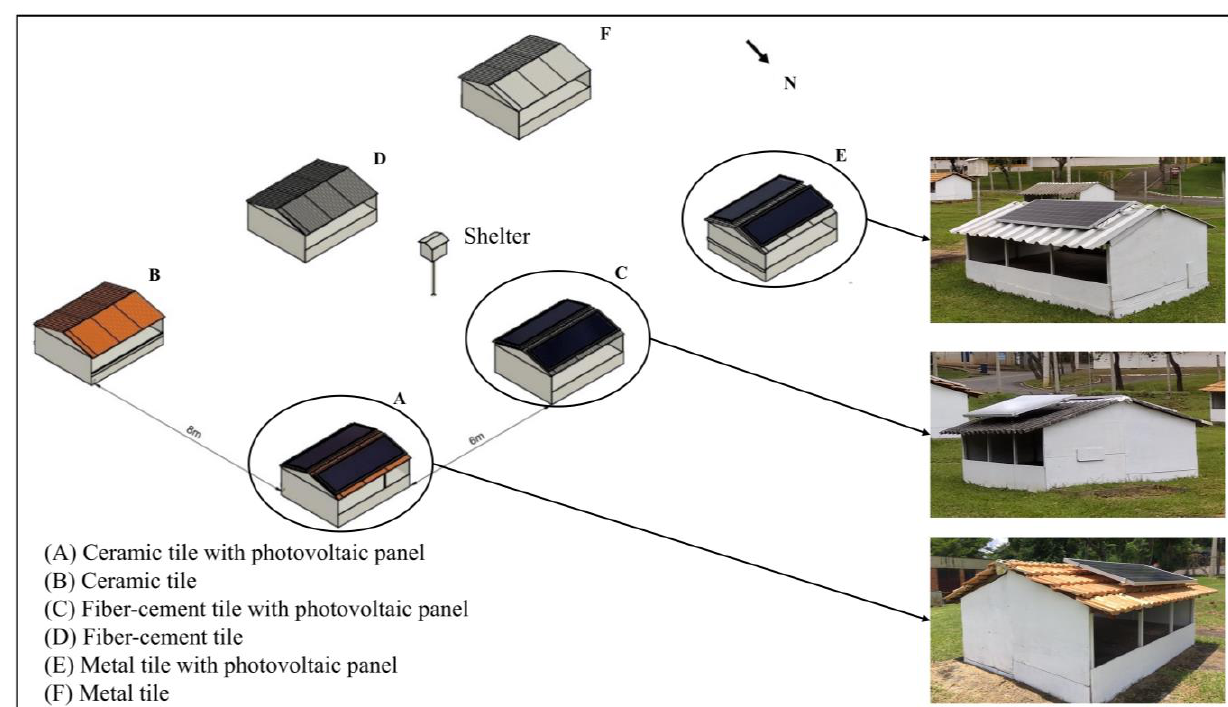
Figure 1. Sketch of the layout of prototypes and